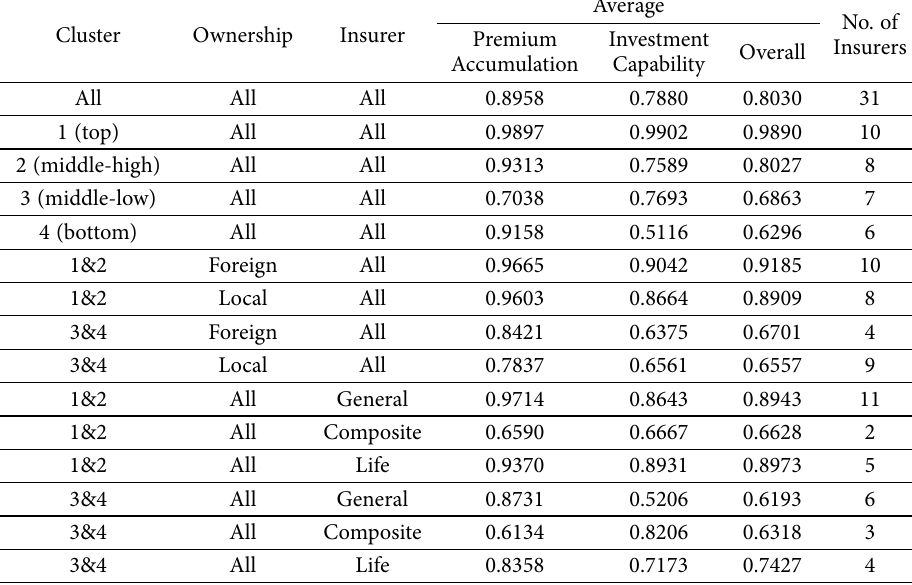
Table 9. K-Means clustering average of efficiencies, by insurer and ownership types Average No. of Cluster Ownership Insurer InsurersPremium Investment Overall Accumulation Capability All All 0.8958